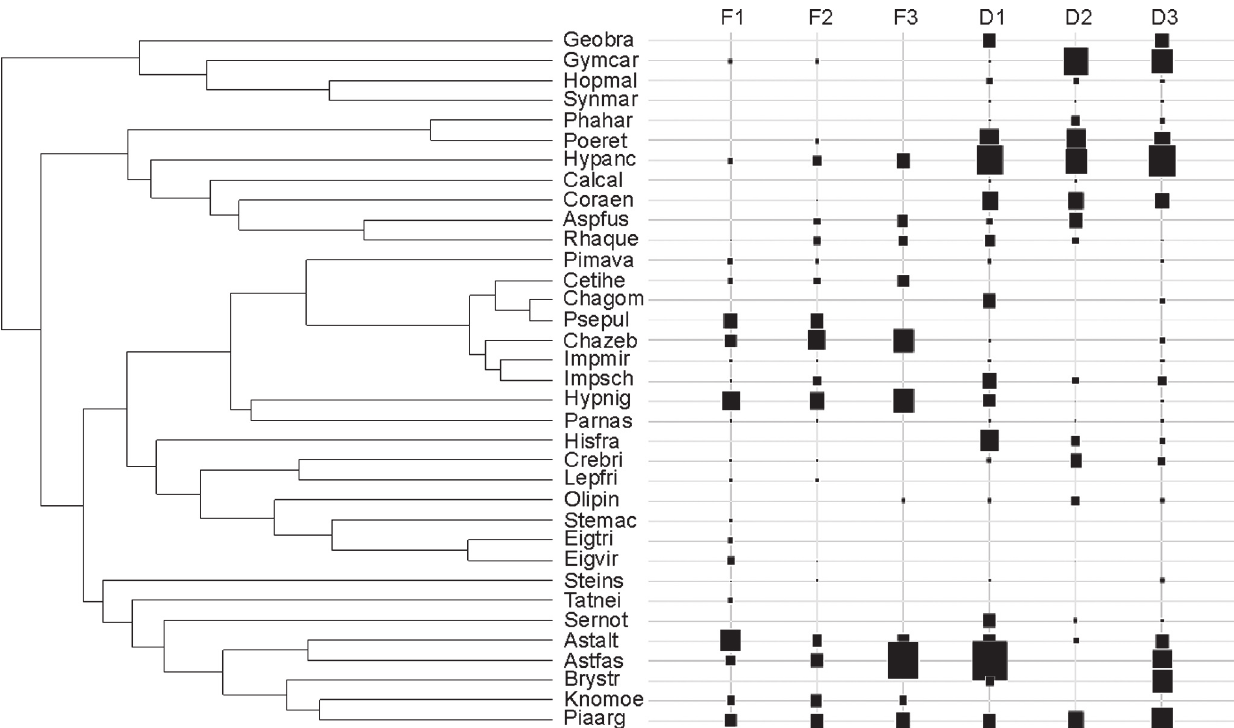
Fig. 2. Dendrogram of the functional similarities of the 35 fish species included in the analyses. Mean species abundances within the forested (F1-F3) and deforested (D1-D3) streams are represented by the sizes of the black squares. Species names are abbreviated according to Table